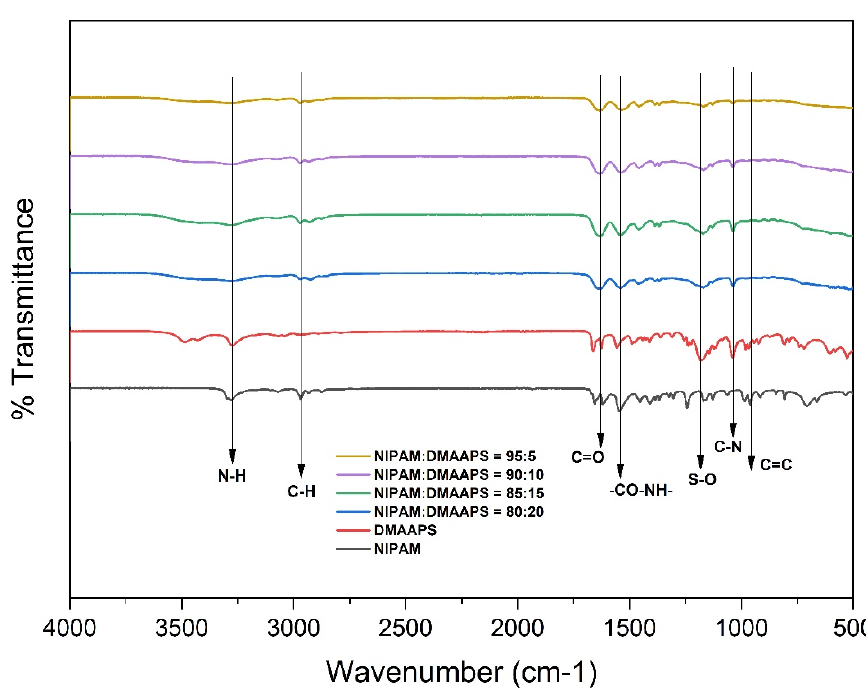
Figure 1. FTIR spectra of NIPAAM, DMAAPS, and poly(NIPAAM- co -DMAAPS) gels. The wavenumber of each functional groups of poly(NIPAAM-co-DMAAPS) gels and its constituent monomer is shown in Table 1 which represent the FTIR spectra of Figure 1. Table 1. Functional groups observed in FTIR spectra of NIPAAM, DMAAPS, and poly(NIPAAM- co -DMAAPS) gels.